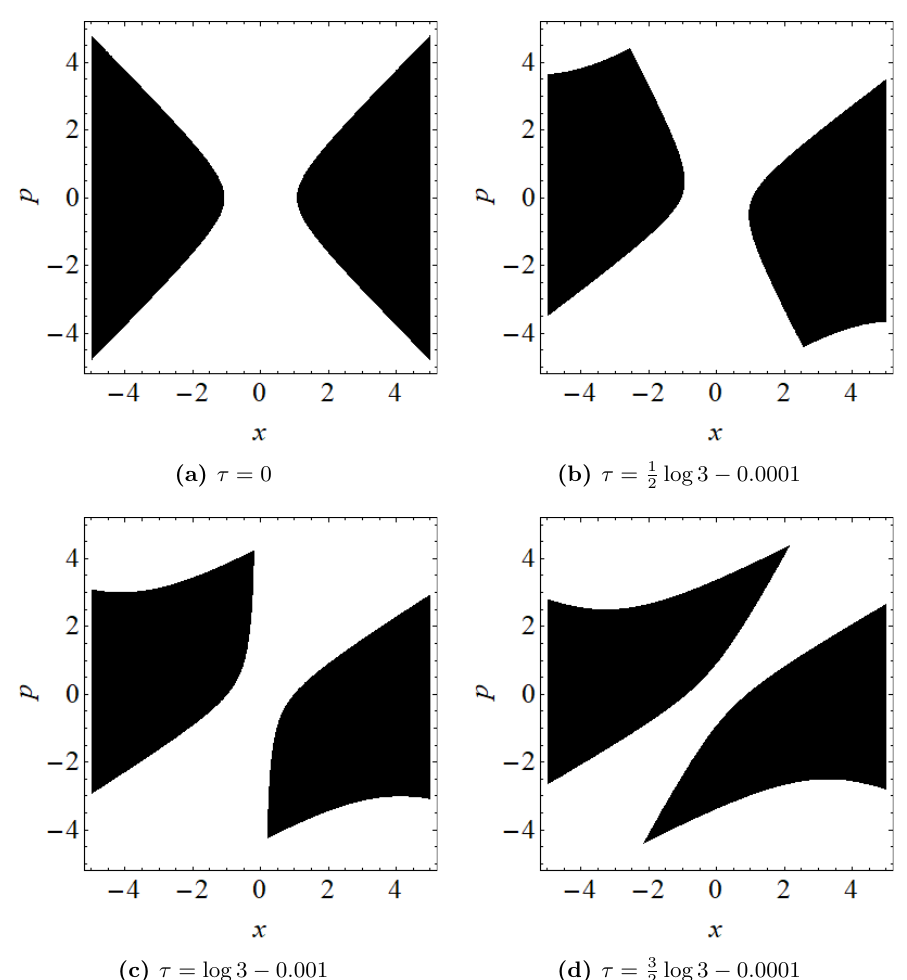
Figure 12. Time evolution of phase space density u ( x; p; (cid:28) ) for the potential with a cuto(cid:11) at x = (cid:6) l= 2 after abrupt quench. Choose ! 0 = 2 ! 1 = 1, l= 2 =